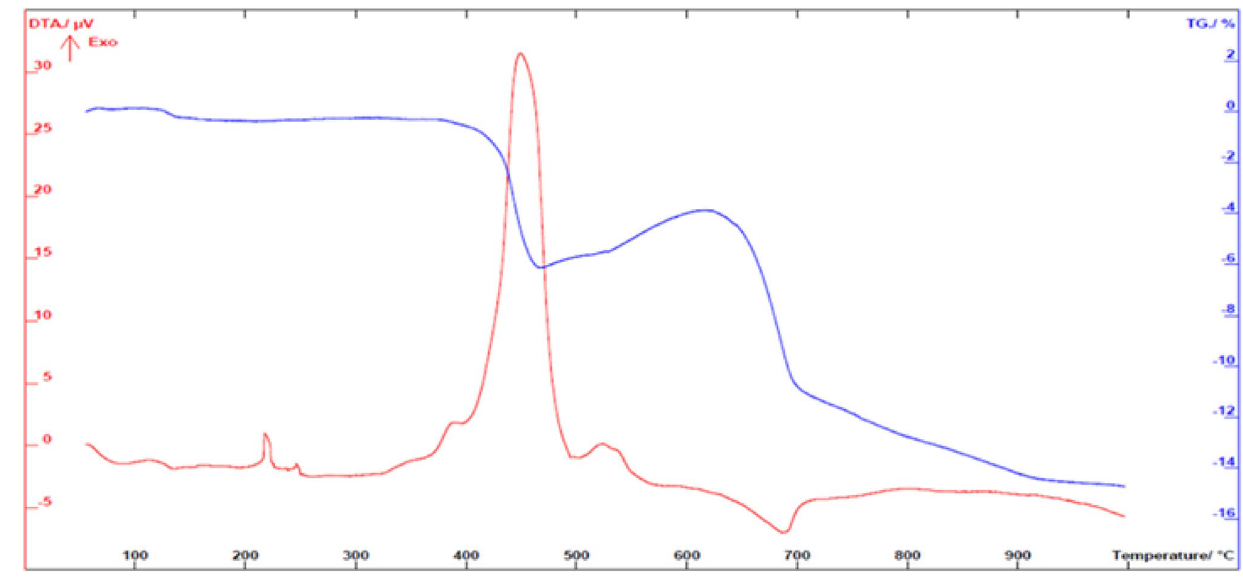
Fig. 7 Mine tailing thermal